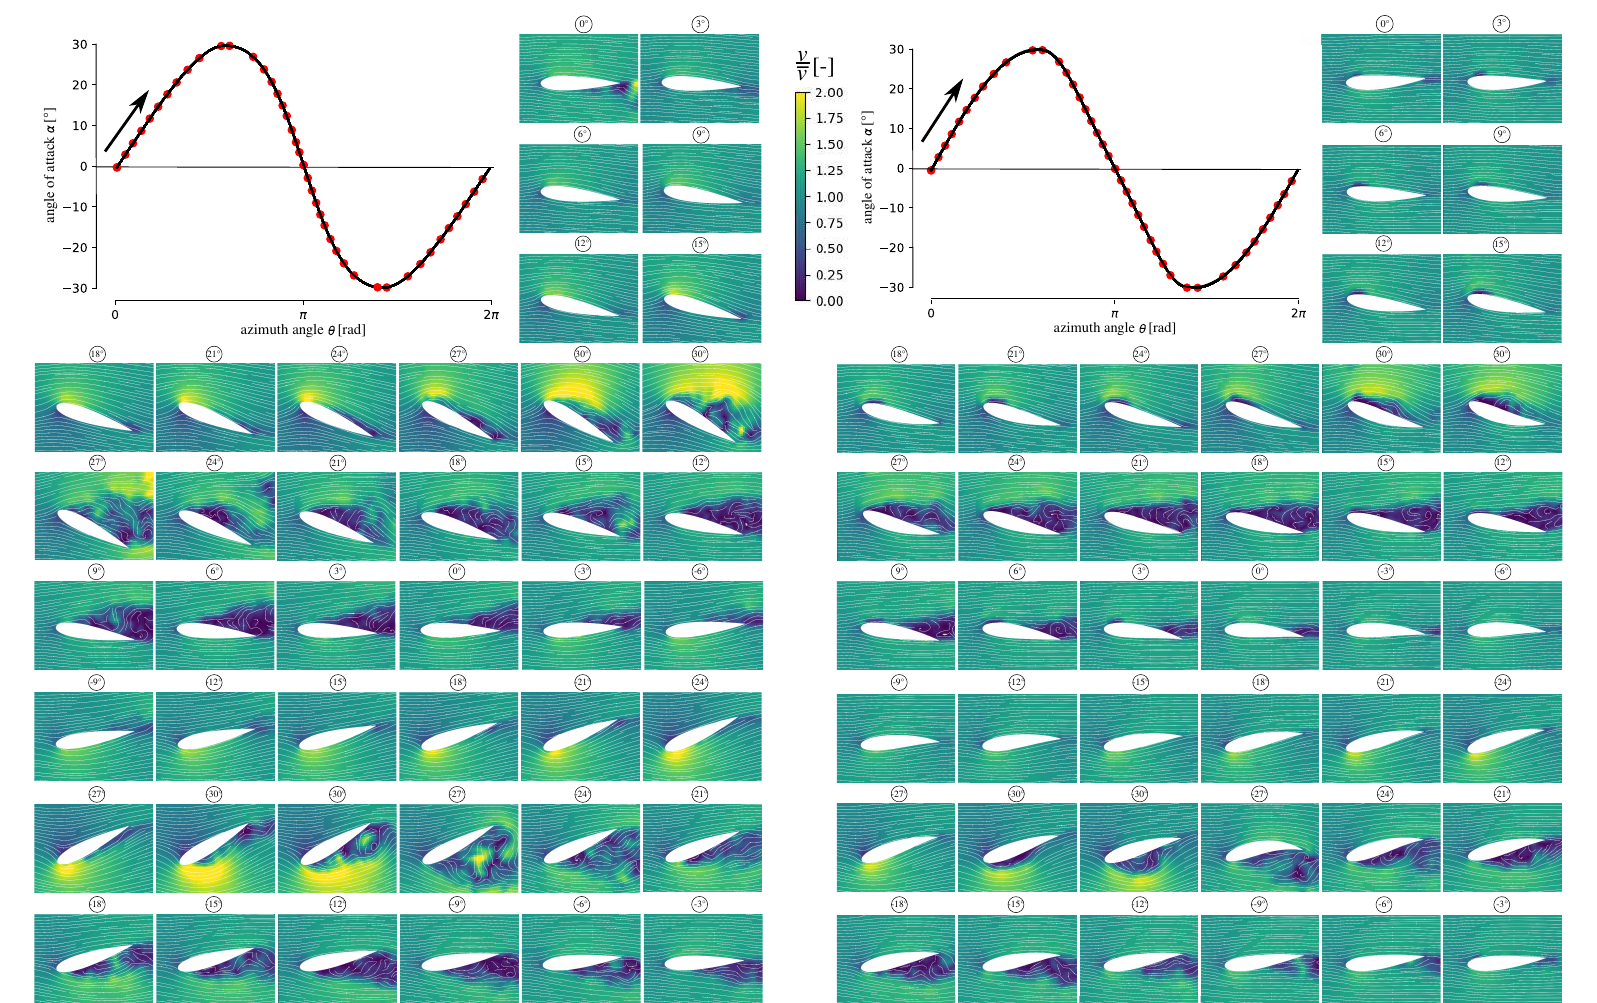
Figure 8. Flow fields for selected angles of incidence of one period of the oscillating pitch motion. The top-left diagram shows the pitch trajectory. The red points in the diagrams show the phase angle of the flow fields. ( Left ) Deep dynamic stall on a rigid NACA0018 hydrofoil at k = 0.24 for λ = 2 and σ = 1.5. Three-dimensional, chaotic structures with multiple, partly counter-rotating vortices are found in the separated zone. ( Right ) Flexible hydrofoil at k = 0.24 for λ = 2 and σ =